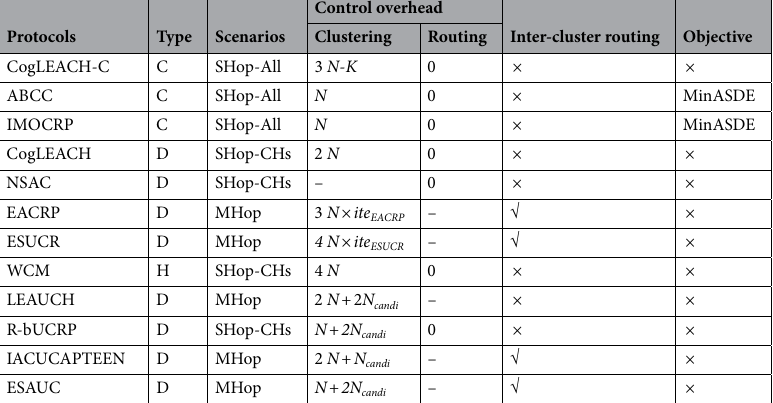
Table 1. Characteristics analysis of existing clustering protocols for CRSNs. C: centralized, D: distributed, H: hybrid; SHop-All: single-hop communication between all nodes and the sink, SHop-CHs: single-hop communication between CHs and the sink, MHop: multi-hop communication; MinASDE: minimize the average node energy consumption and the standard deviation of node residual energy; N is the number of living nodes in current round; K is the optimal number of CHs; ite EACRP and ite ESUCR are the number of merging iterations performed by EACRP and ESUCR, respectively; N candi is the number of candidate CHs in uneven clustering protocols; ― represents that the corresponding value is unable to be explicitly quantified; × denotes the corresponding problem has not been solved while √ represents the opposite